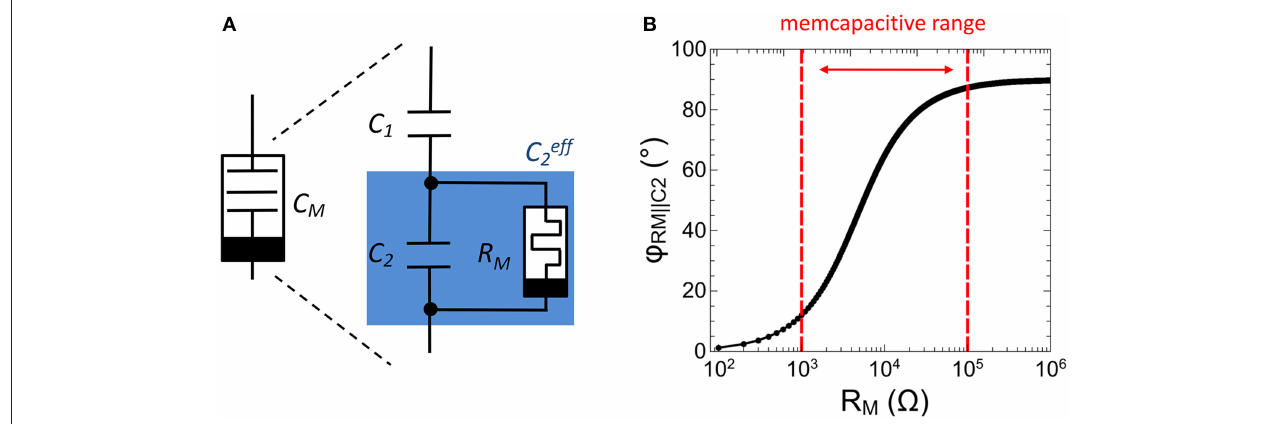
FIGURE 4 | Experimental realization of a memcapacitor: (A) Schematic drawing of the memcapactitive circuit including a memristive device. (B) Calculated impedance phase ϕ